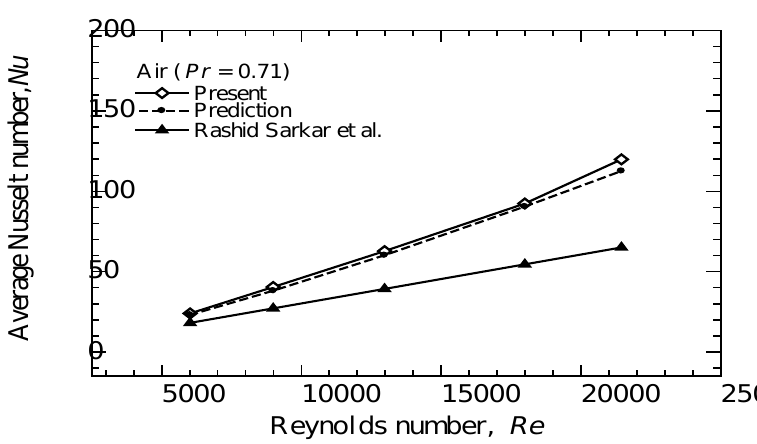
Figure 16: Prediction of heat transfer coefficients for wire-coil inserted tube (Pitch, P c =50 mm, helix angles, α =45 0 ).